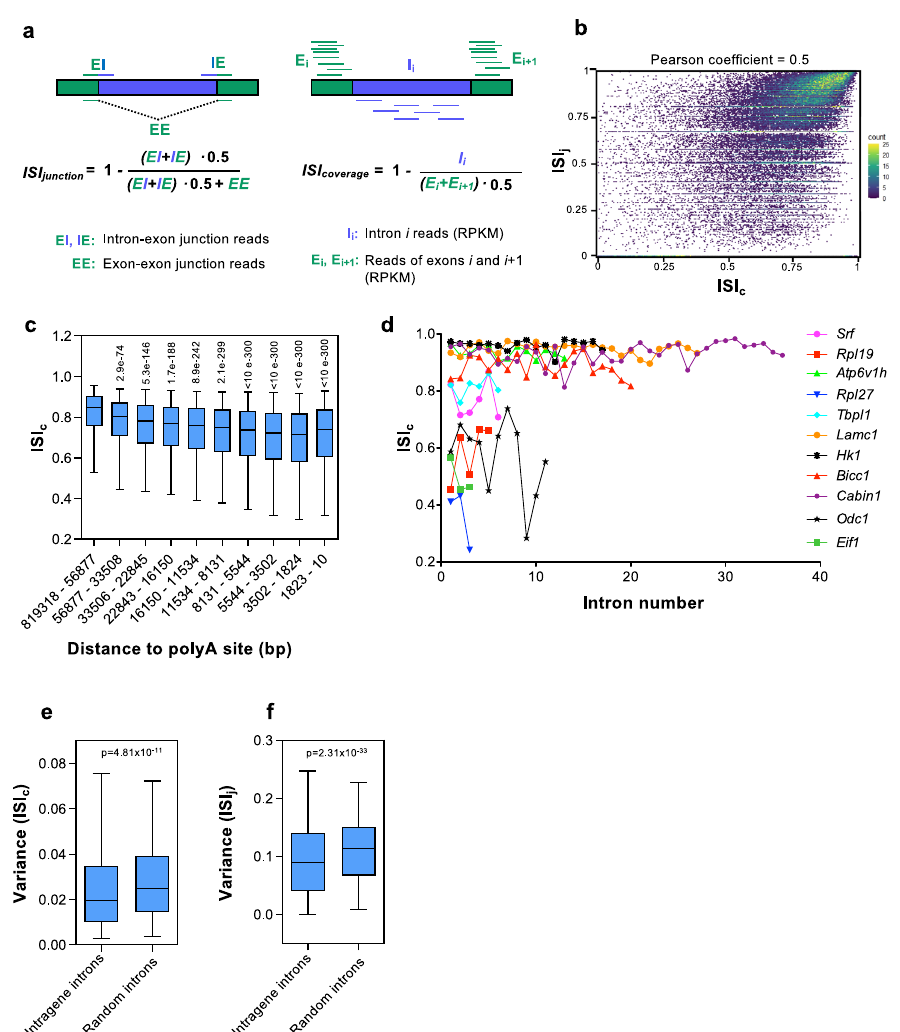
Fig. 1 Intron splicing ef fi ciency. a Schematics outlining the two approaches used to measure the intron splicing index (ISI): junction-based ISI (ISI j ) and coverage-based ISI (ISI c ). RPKM, reads per kilobase per million mapped reads. b Scatter plot of ISI j and ISI c values correlation. Each point represents the ISI j and ISI c of a certain intron. c Effect of intron to polyA site distance on ISI c . Introns were divided into ten deciles depending on their distance to the polyA site. Unpaired Student ’ s t -test p-values of the indicated decile with respect to the fi rst decile are shown. d ISI c level of the indicated introns of eleven different genes. e , f Variance of ISI c ( e ) and ISI j ( f ) values across introns within the same gene or the same number of randomly sampled introns. Unpaired Student ’ s t -test p-values are shown. Sample size ( n ) of all sets of data are provided in Supplementary Data